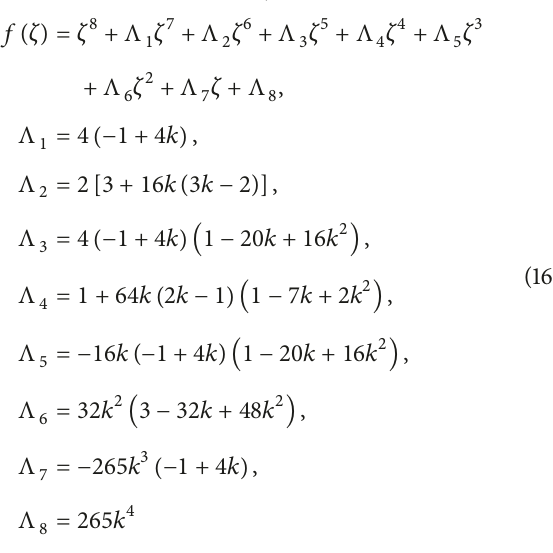
and then the characteristic polynomial becomes as